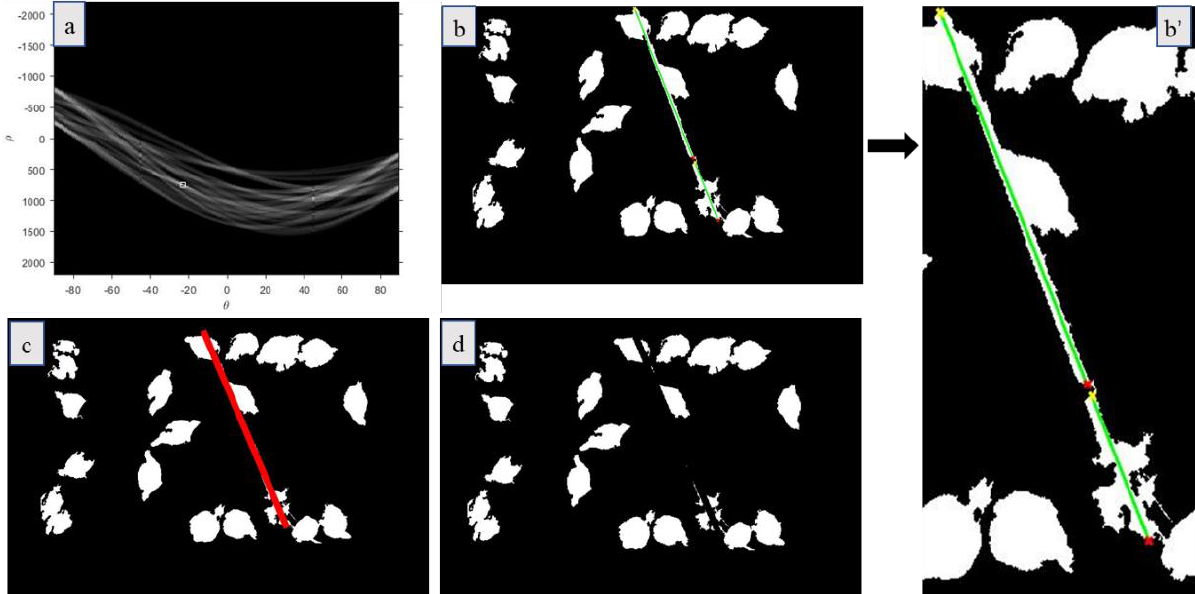
Figure 3. The process for pipe area detection and removal. The white box in ( a ) is the maximum peak point; In ( b ), it shows all the lines (green) that have passed the peak point with the yellow × indicating the starting point of the lines and the red × indicating the ending point of the lines. The drinking zone was zoomed-in ( b’ ); In ( c ), the red area is the pipe area; and ( d ) is the result of pipe area